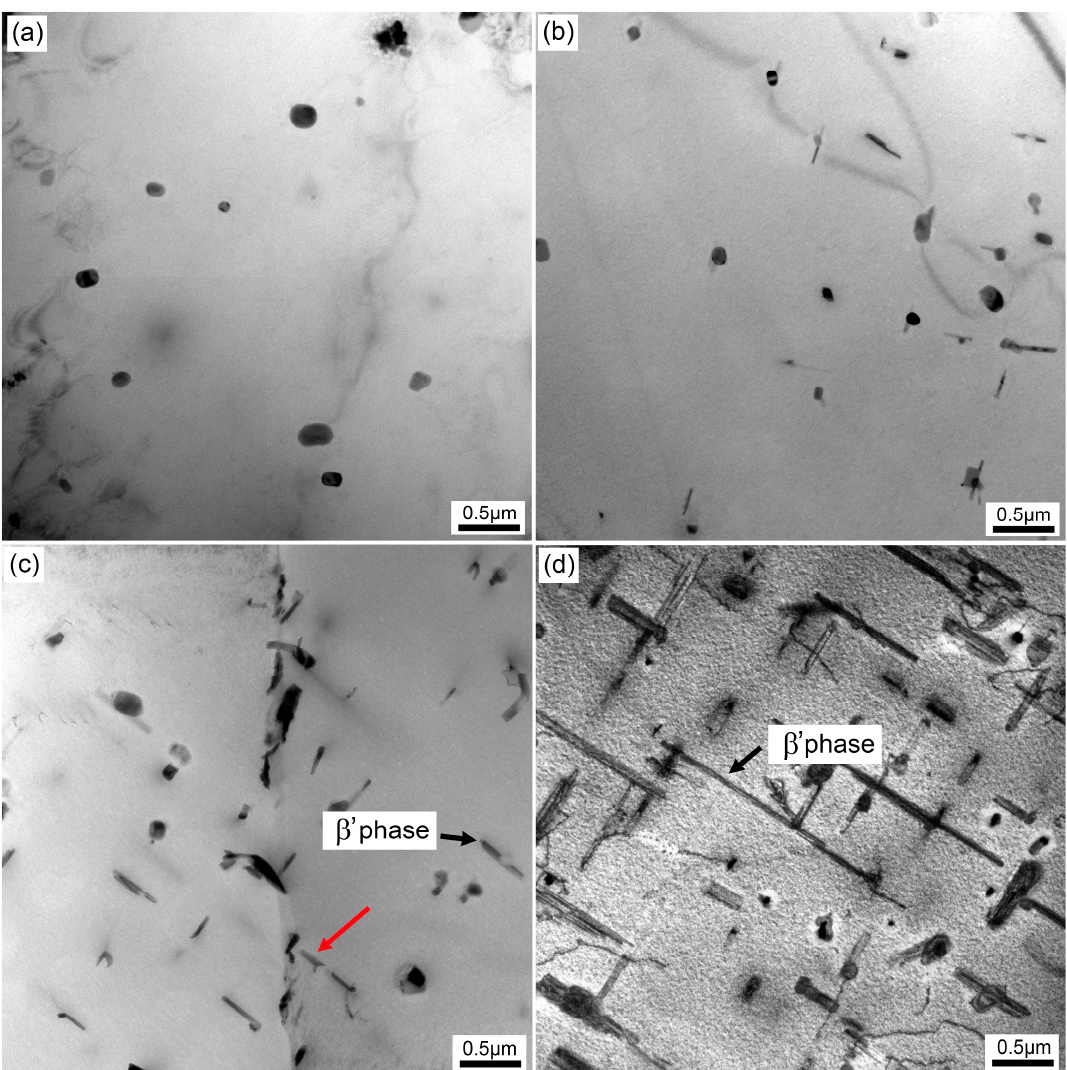
Figure 11. TEM bright-field images of samples with different quenching rates after paint bake-hardening at 185 °C for 4 h: ( a ) 58.9 °C/s, ( b ) 7.0 °C/s, ( c ) 2.8 °C/s, and ( d ) 1.6 °C/s.